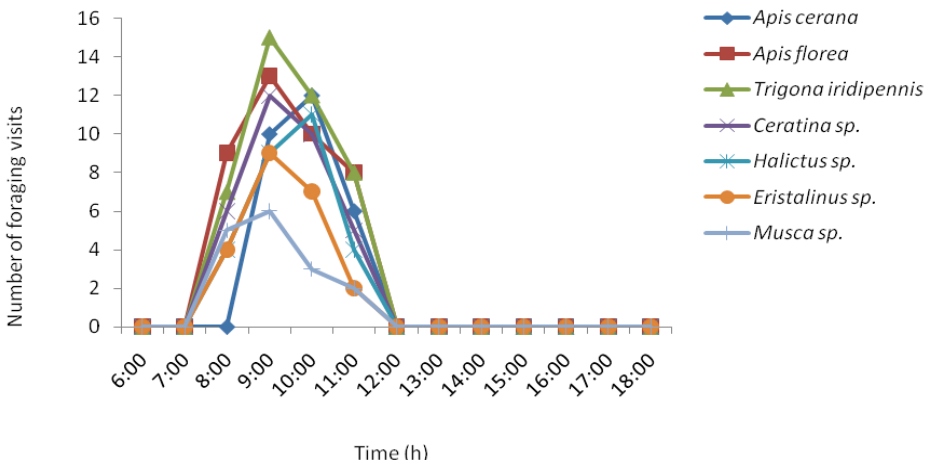
Figure 1. Hourly foraging visits of bees and flies on Mollugo